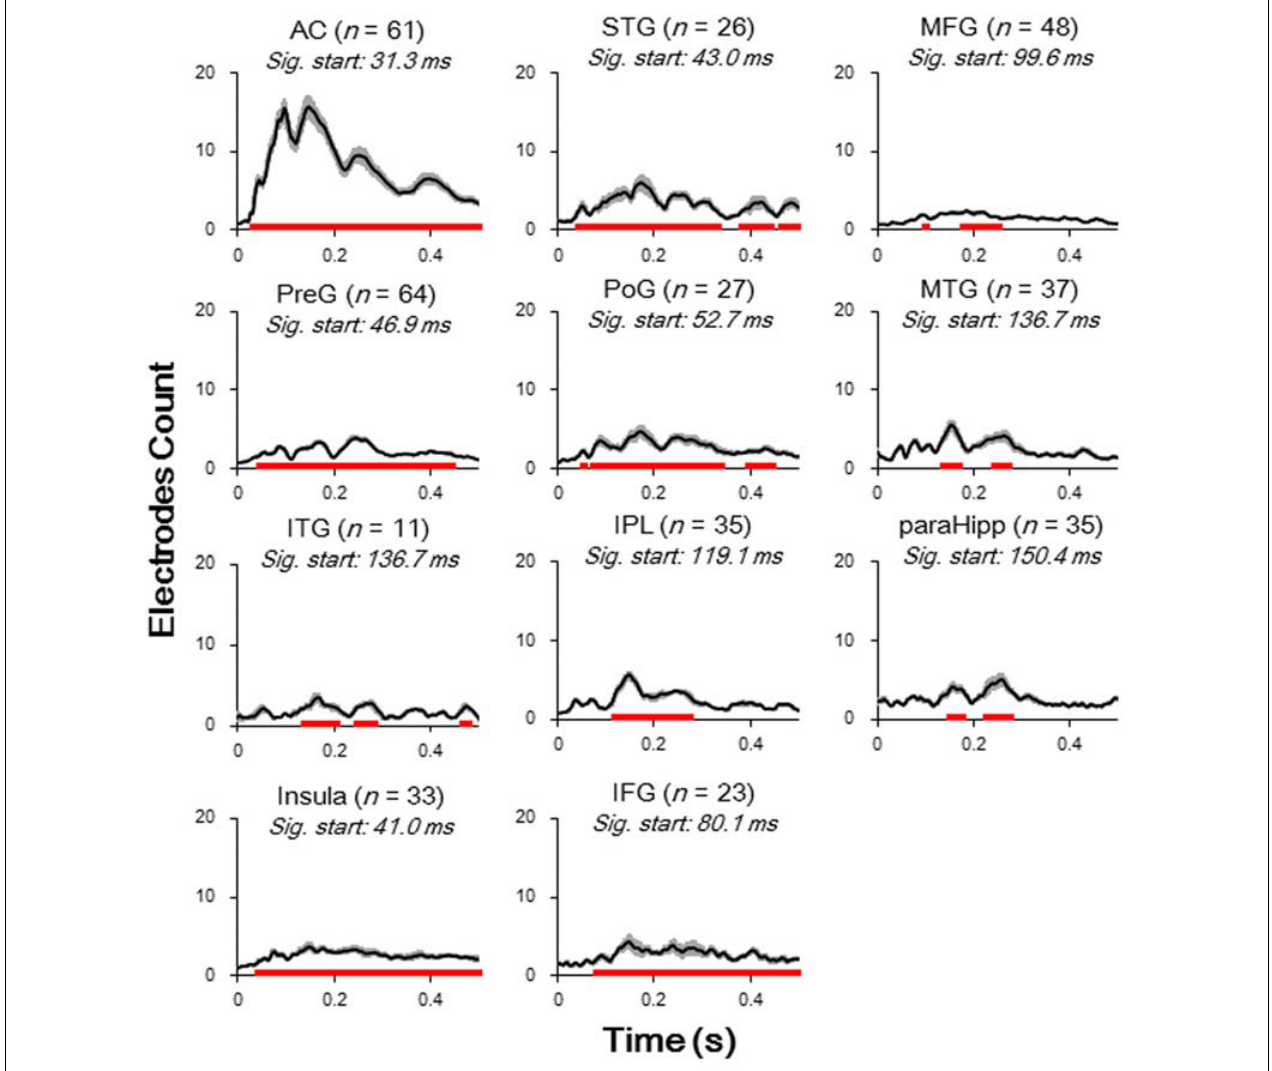
FIGURE 3 | Averaged waveform (absolute value) for each of significantly activated brain areas. Student t -tests against baseline (–50 to 0 ms before sound onset) with Bonferroni correction were conducted to decide the significance. Black lines , mean value; Gray areas , standard error; Red bars , significant temporal area; Sig. start , the time point when the significance started to occur; AC , auditory cortex; PreG , precentral gyrus; STG , superior temporal gyrus; poG , postcentral gyrus; IPL , inferior parietal lobule; IFG , inferior frontal gyrus; MFG , middle frontal gyrus; MTG , middle temporal gyrus; ParaHipp , para-hippocampus; ITG , inferior temporal